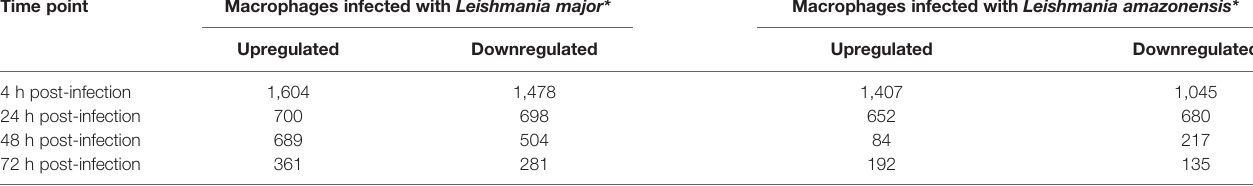
TABLE 1 | Differentially expressed